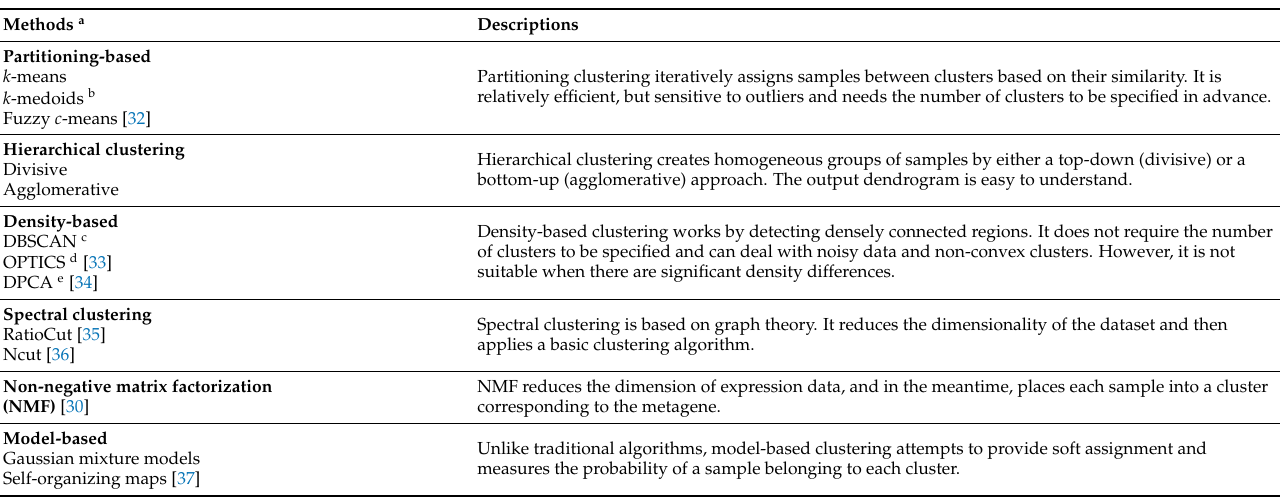
Table 1. Clustering algorithms for subtype